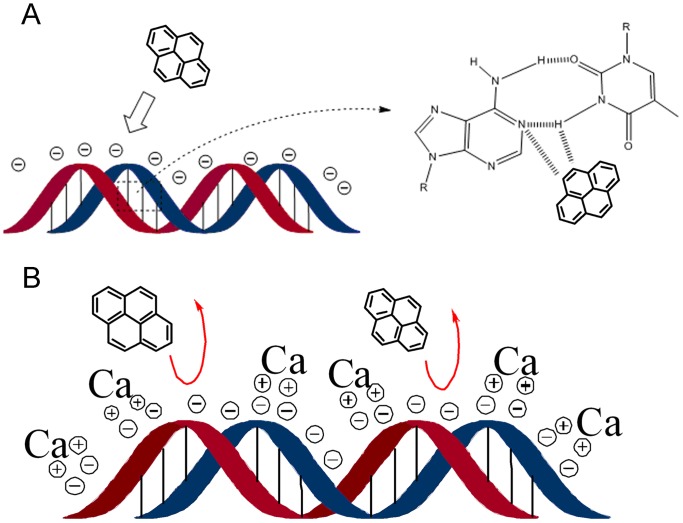
Diagram of the mechanism of Ca2+-inhibited PAH adsorption via blocking of the binding site in plasmid DNA.A hydrophobic interaction between pyrene and DNA bases occurred via a phosphate backbone structure (A). Ca2+-inhibition of the interaction between pyrene and DNA occurred via the capture of PAHs by DNA, thereby blocking the phosphate backbone structure of the DNA periphery (B).